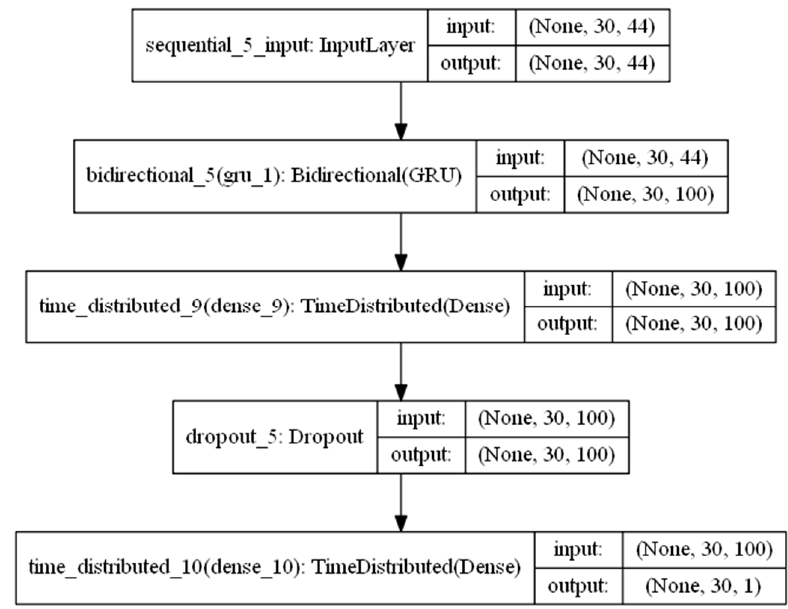
Figure 14. Model based on Architecture 2: many-to-many